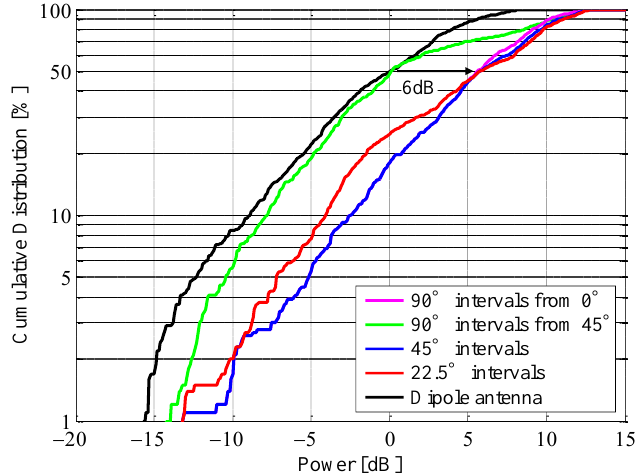
Figure 26. CDF characteristics of received power of each division pattern.